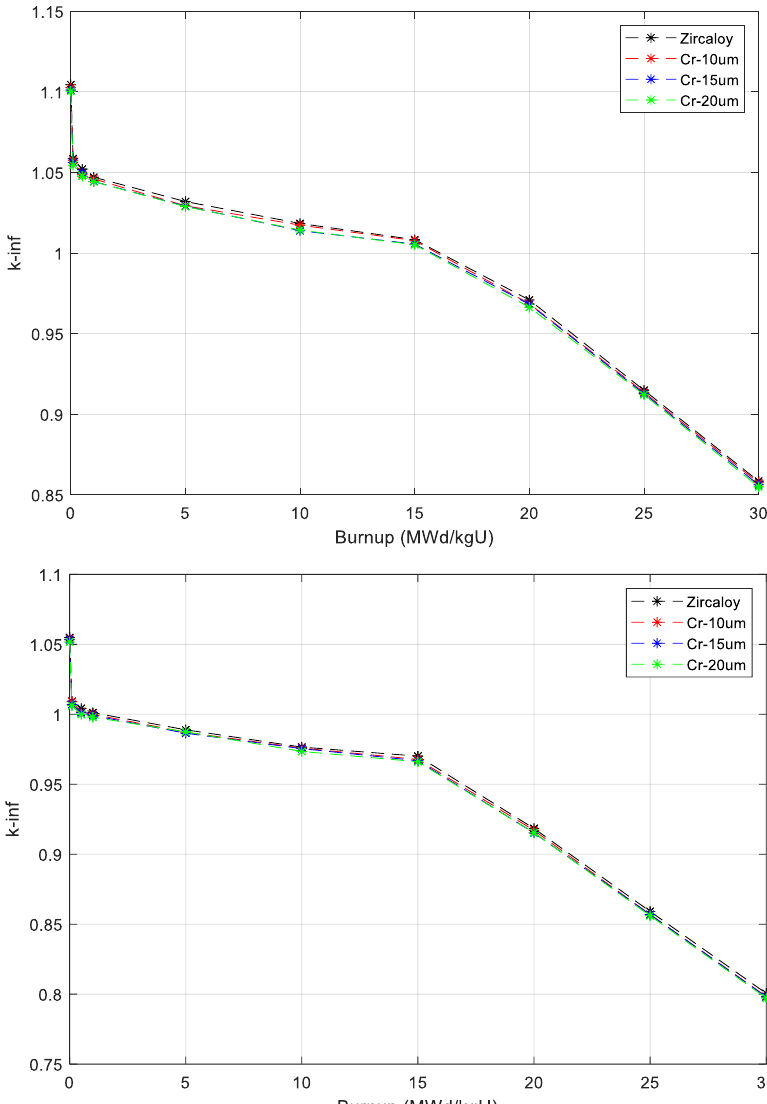
Figure 6. K inf versus burnup days and fuel reactivity compared to the reference cladding for c3 and b1 assemblies. Table 6. k inf values and reactivity difference at BOC for APR-1400 fuel assemblies.